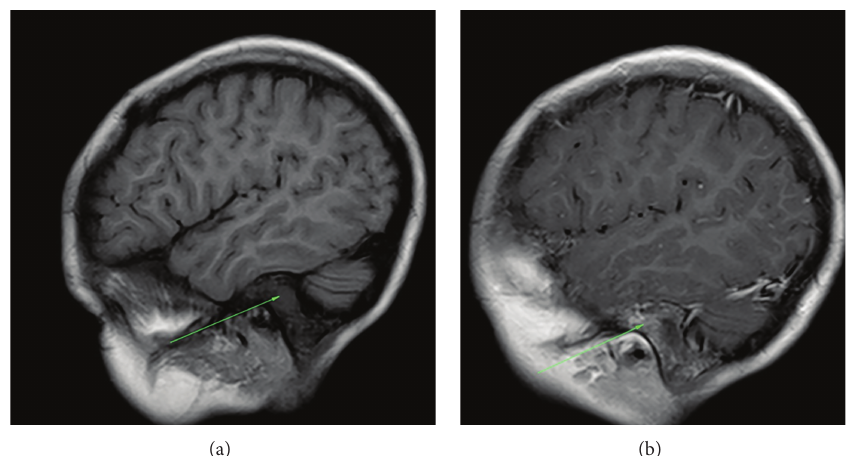
Figure 6: (a) Precontrast T1 FSE. Opacified left mastoid sinus. (b) Postcontrast T1 FSE. There is extensive mural enhancement postcontrast.